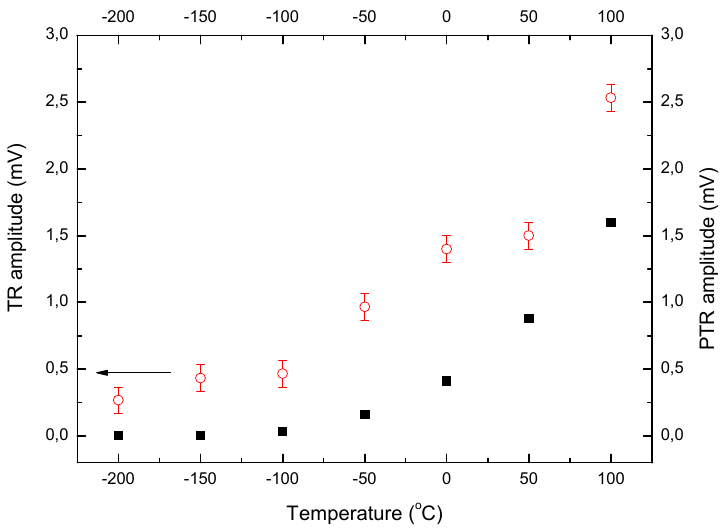
Figure 2. Temperature-dependent of the PTR and TR amplitudes at 1 kHz for a GaAs wafer covered by 50 layer of Ti and 2 µ m AlGaAs thin layer with 100 nm of gold layer, respectively. The data are not normalized. The signals were depicted for 1 kHz. Note that PTR amplitude is very stable with error bars within experimental